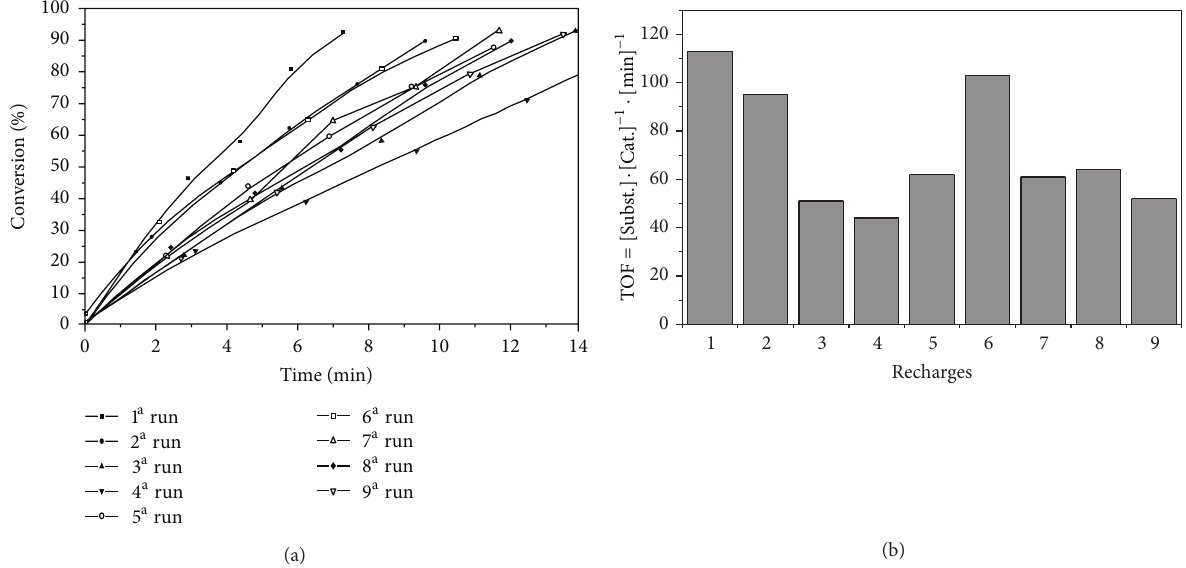
Figure 5: Recycling experiments for the hydrogenation of 1-hexene. Conditions: 100mg of Pd(0)/SiO 2 /HF ( ca. 2%), 1-hexene (1g, 12mmol), 4atm of H 2 (constant pressure), temperature 75 ∘